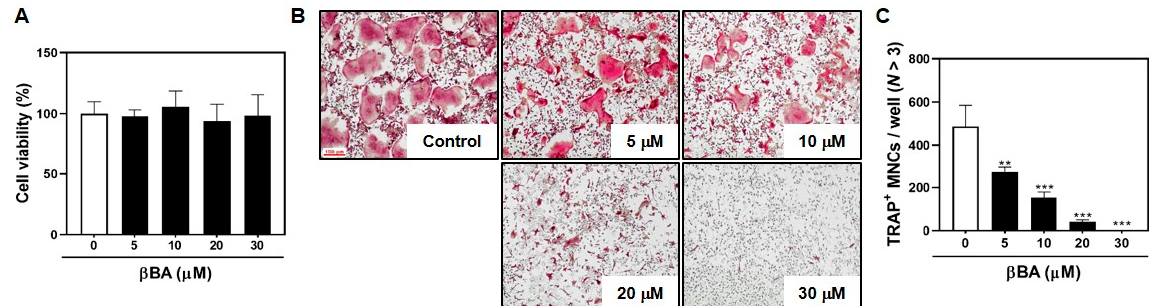
Figure 1. β -boswellic acid ( β BA) inhibits RANKL-induced osteoclast differentiation without cytotoxicity. ( A ) Mouse bone marrow-derived macrophages (BMMs) were cultured for 3 days at the indicated concentration of β BA in the presence of M-CSF (30 ng/mL). Cell viability was analyzed by XTT assay. ( B ) BMMs were cultured for 4 days in the presence of M-CSF (30 ng/mL) and RANKL (100 ng/mL) with the control (DMSO) or β BA at the indicated concentration. After culturing, cells were fixed with 3.7% formalin, permeabilized with 0.1% Triton X-100, and stained with TRAP staining solution. ( C ) TRAP-positive multinucleated cells (TRAP + MNCs; N > 3) were counted as osteoclasts. Scale bar, 100 μ m. Data represent means ± SD (n = 3). ** p < 0.01, *** p < 0.001 as compared with DMSO control.